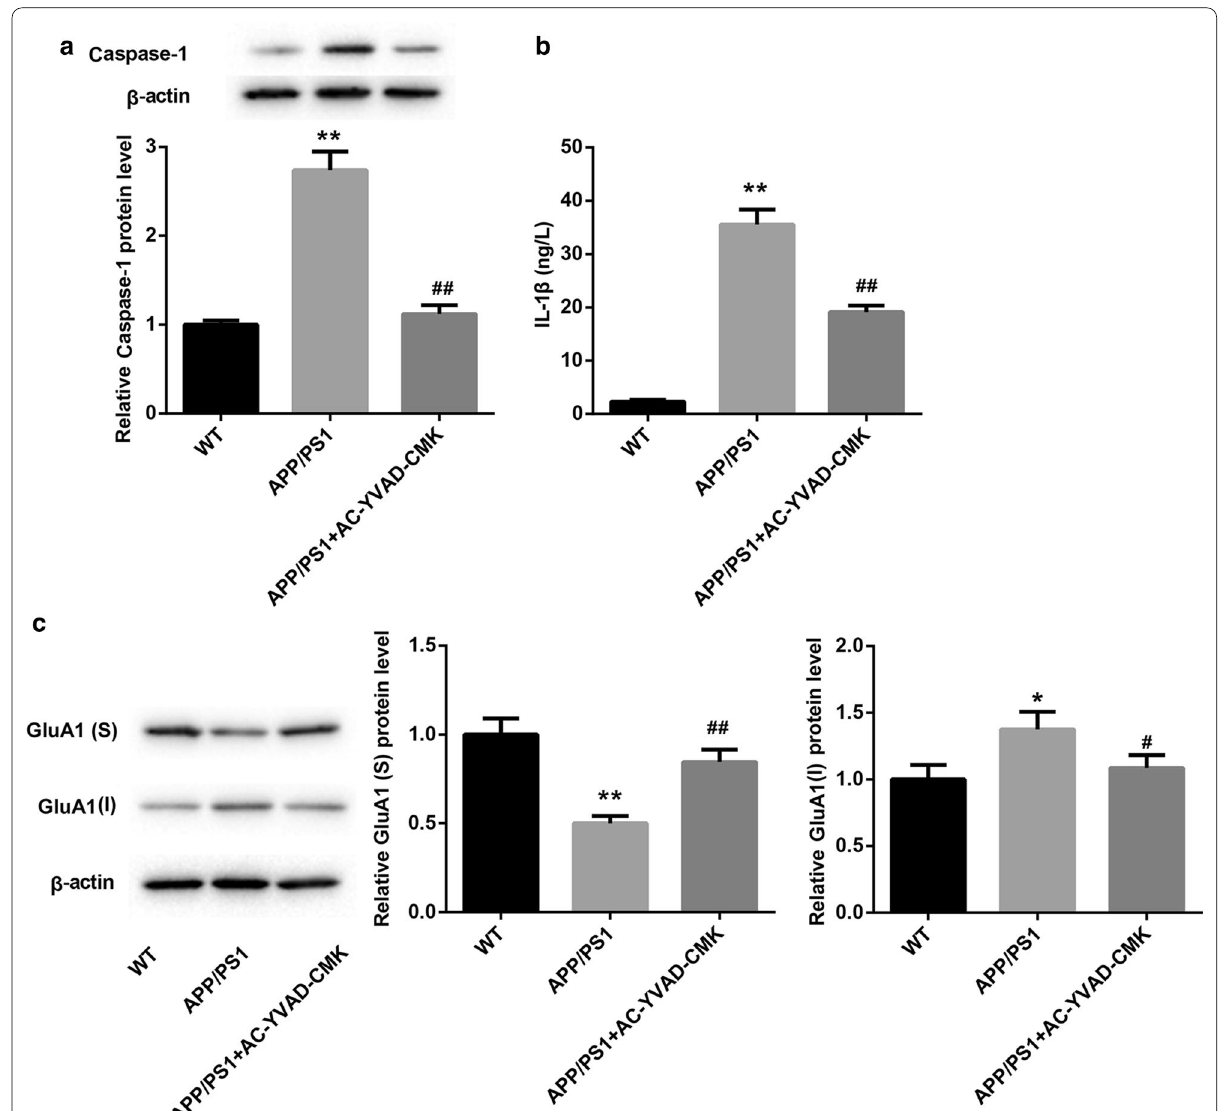
Fig. 2 AC-YVAD-CMK promoted membrane transport of GluA1 in APP/PS1 mice. APP/PS1 mice were intraperitoneally injected with AC-YVAD-CMK or DMSO. WT C57/BL6 mice were served as control. a WB was performed to detect the expression of caspase-1 in the hippocampal tissues of mice. b ELISA was performed to assess the levels of IL-1β in the hippocampal tissues of mice. c WB was performed to estimate the expression of GluA1 in the hippocampal tissues of mice. S: surface; I: intracellular. (One-way ANOVA; * P < 0.05, ** P < 0.01 vs. WT group; # P < 0.05, ## P < 0.01 vs. APP/PS1